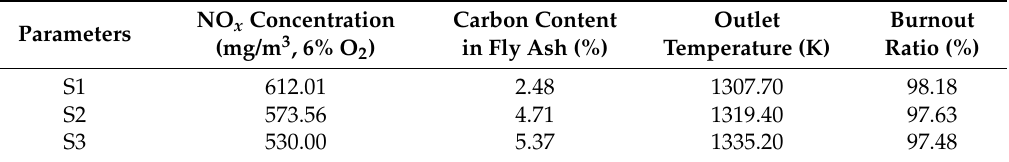
Figure 13. The average temperature and species concentrations along the height of furnace (S1 refers to the original OFA nozzles of the boiler at the height of 31 m and S2 and S3 refer to the OFA nozzles at the height of 34 m and 39 m, respectively). Table 5. Some indicators at the furnace outlet under various OFA arrangements.